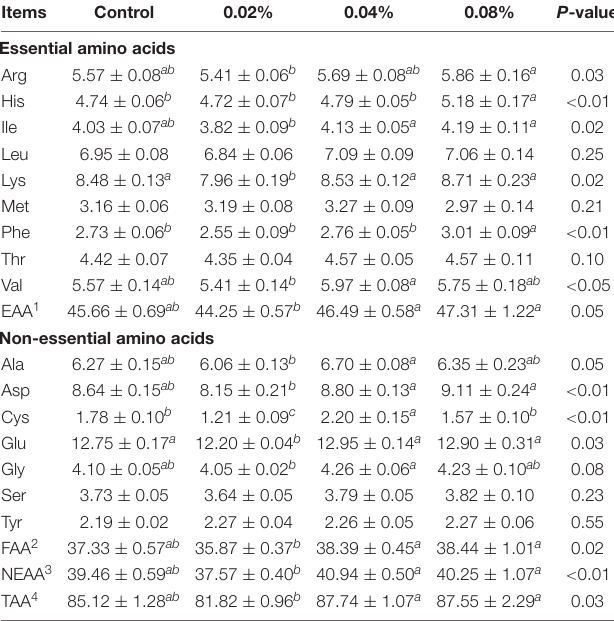
TABLE 7 | Effects of different levels of dietary CGA supplementation on the content of hydrolyzed amino acids in BF muscle of finishing pigs ( µ g/100 mg).